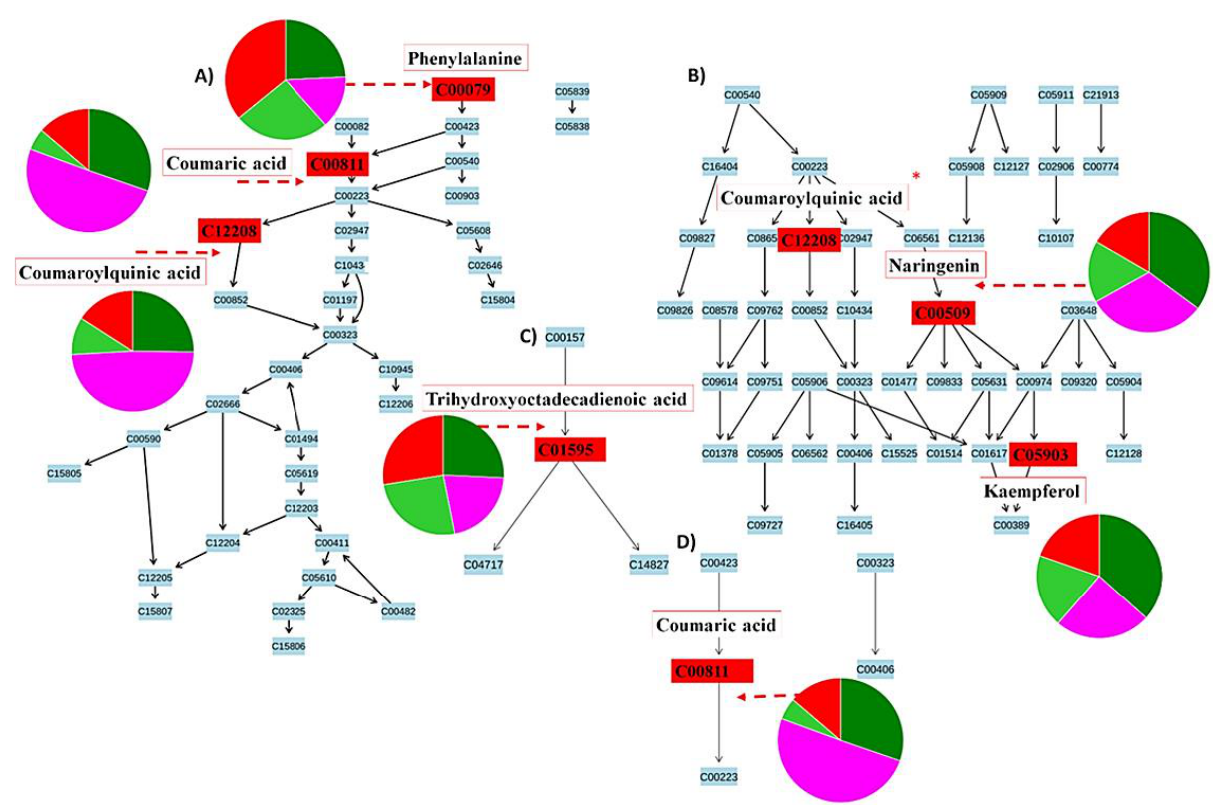
Figure 9. Pathways flagged from metabolomics analysis using MetaboAnalyst software. Signatory metabolites involved in each pathway are illustrated in the form of pie charts according to their relative intensities and presence across the different cultivars and treated groups. ( A ) The phenylpropanoid pathway, ( B ) the flavonoid pathway overlapping with the phenylpropanoid pathway (*), and ( C ) the linoleic acid pathway that showed the highest impact after pathway enrichment analysis, along with ( D ), the general secondary metabolite biosynthesis pathway. Some limitations in MetaboAnalyst prevented the mapping of all annotated metabolites (Table 1). The different colours indicate “ Dunnart ” infected (pink), “ Dunnart control ” (dark green), “ SWK001 ” infected (red) and “ SWK001 ” control (light green). The metabolites synthesised via the phenylpropanoid-and flavonoid pathways are some of the most widely occurring secondary metabolites that are involved in plant development and defence against abiotic and biotic stresses, such as phenolics, flavonoids, coumarins and lignin [45,46]. Both pathways are initiated with the conversion of phenylalanine to p -coumaroyl-CoA and have some overlap, as shown (*) in Figure 9B. The presence and distribution of the phenolic compounds, from both the phenylpropanoid and flavonoid pathways, across the plant kingdom at a cellular, tissue and organ level emphasises the vast biological and biochemical functions important to the survival of plants [47,48]. Phenolics have been known to play important roles in plant-pathogen interactions as either pre-formed (phytoanticipins) or induced anti-pathogenic molecules (phytoalexins) [49]. Linoleic acids (C18:2) are unsaturated fatty acids that are prevalent in plant membranes, hence making them important for plant structure and maintaining water permeability and, additionally, are involved in the formation of jasmonate, which act as signalling molecules in response to tissue damage caused by insects, pathogens, herbivores or mechanical stress [50].